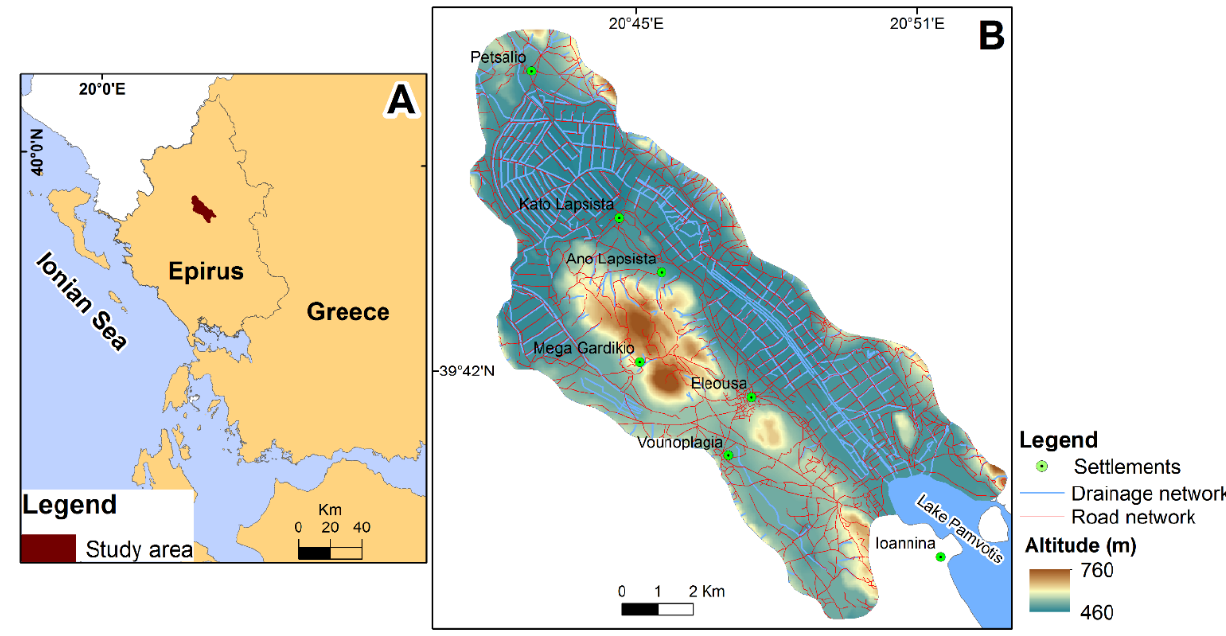
Figure 1. ( A ) Location map of the study area; ( B ) road network, drainage network and elevation of the study area.